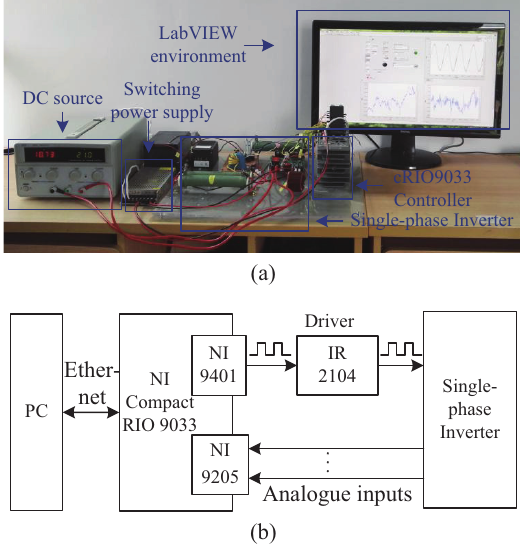
Figure 8. Rapid control prototype: ( a ) experimental platform; and ( b ) block